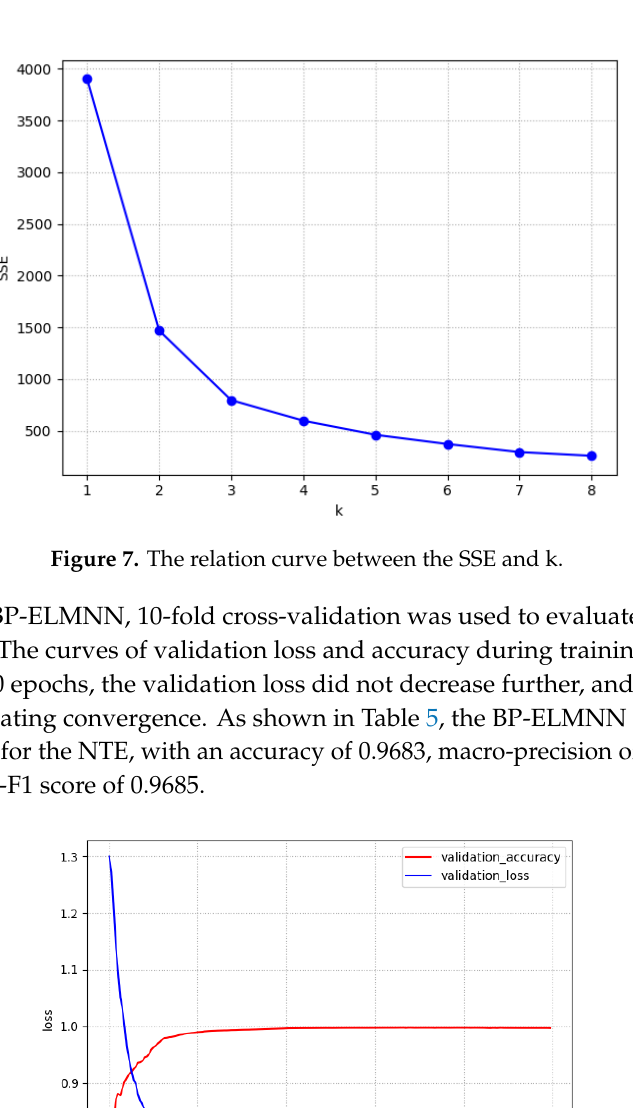
Table 5. The accuracy, macro-precision, macro-recall, and macro-F1 score of the four methods for the NTE.